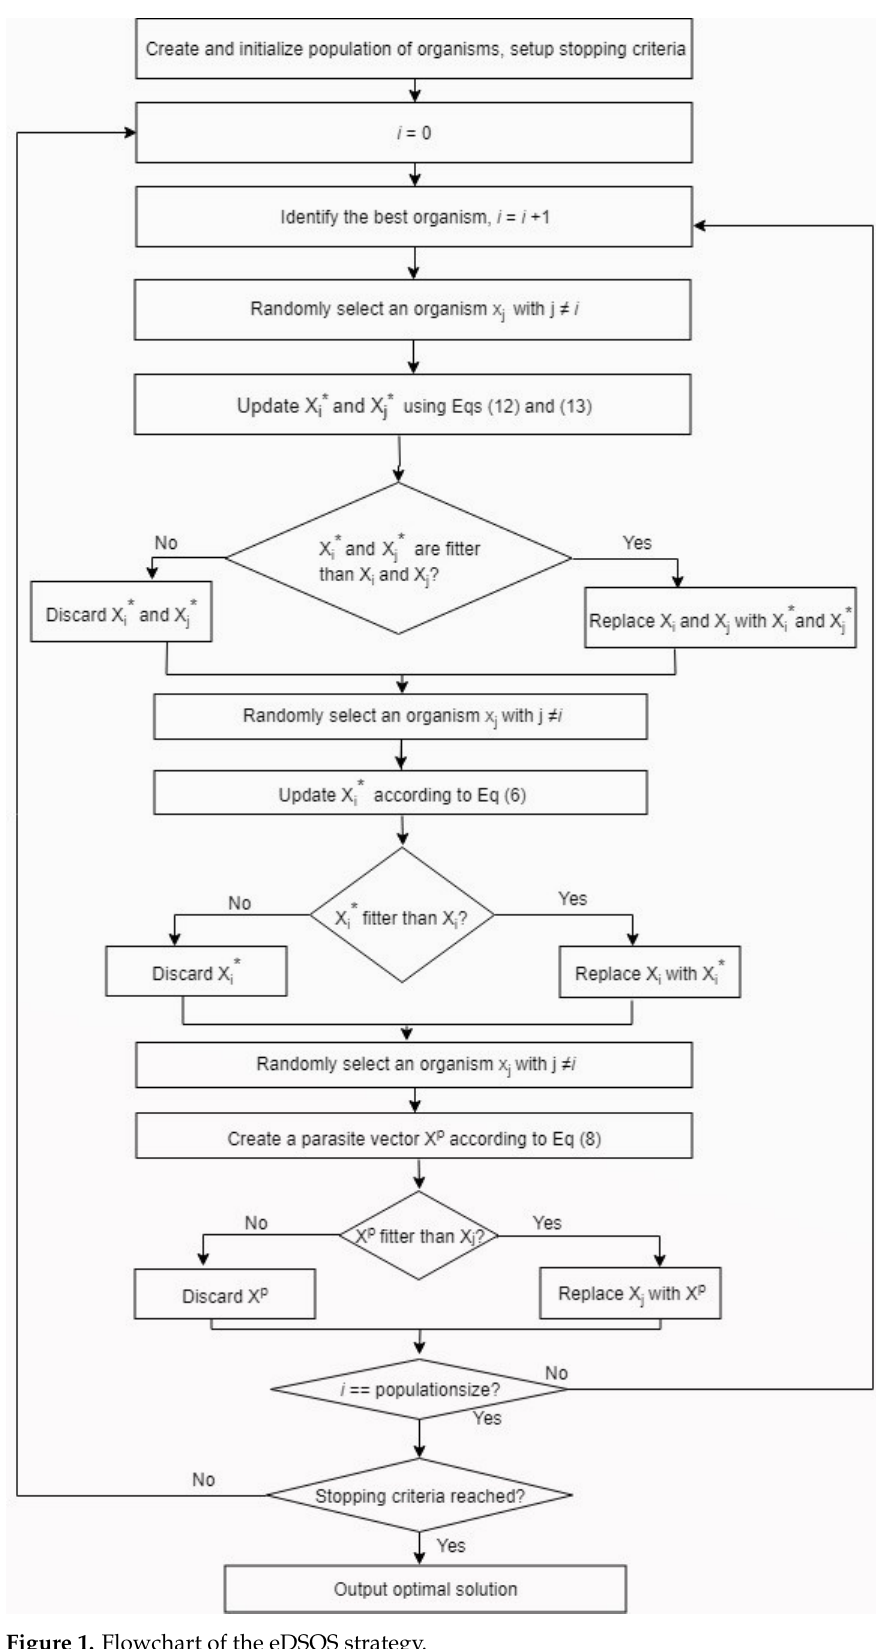
Figure 1. Flowchart of the eDSOS